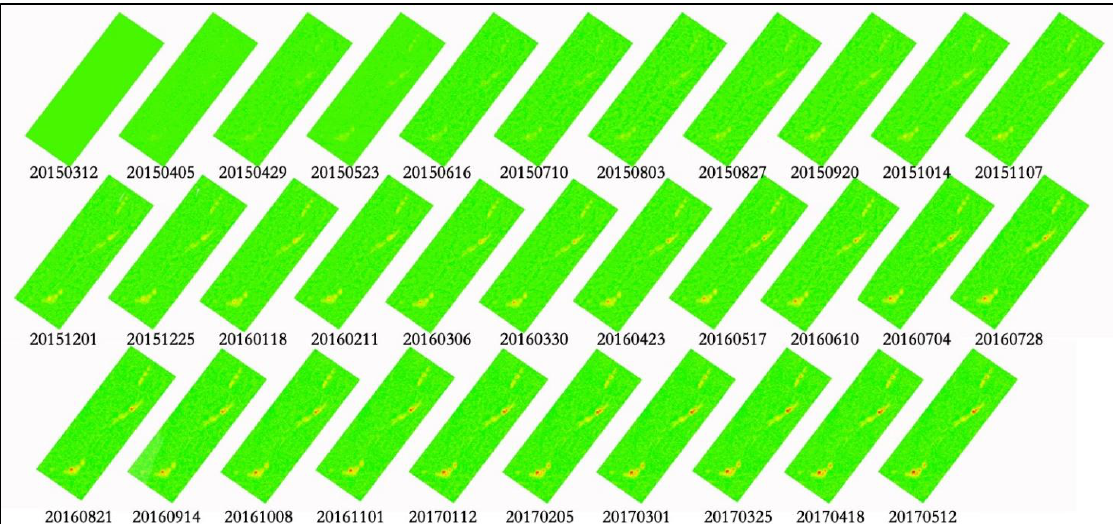
Figure 6. Deformation amount time-series change from 2015 to 2017 northeast forming a deformation zone. Figure 8 is the position of